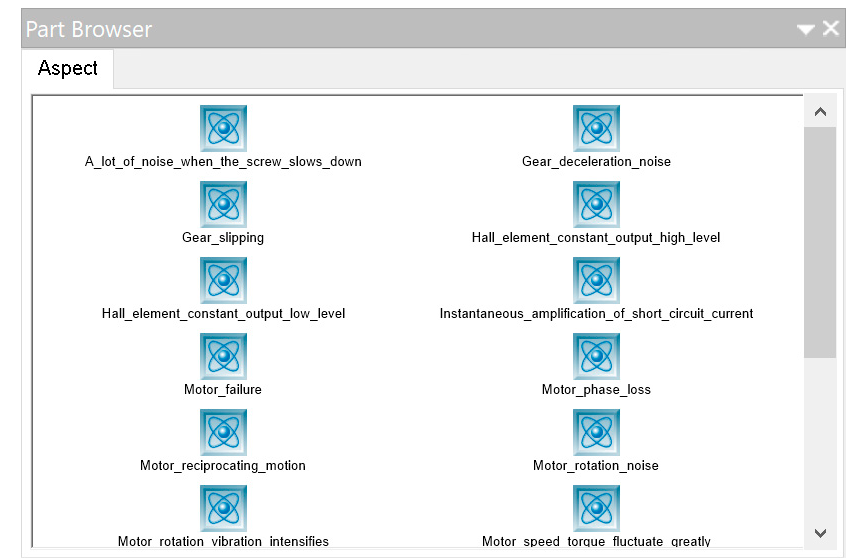
Figure A3. The related submodel of EMA in GME.